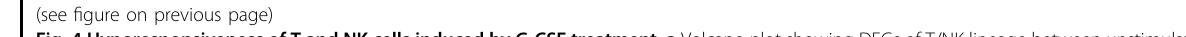
Fig. 4 Hyporesponsiveness of T and NK cells induced by G-CSF treatment. a Volcano plot showing DEGs of T/NK lineage between unstimulated BM and G-BM. DEGs were detected by differential expression analysis (two-sided Student ’ s t -test). Each dot represents a single gene; genes with log 2 (fold change) (logFC) < − 0.25 and logFC > 0.25 were selected and colored in blue and red, respectively. b Metascape network enrichment analysis of DEGs in T/NK cells in G-BM, with top 20 enriched terms and corresponding P values displayed at the bottom. Nodes were colored to re fl ect the memberships of enriched terms (left) and statistical P values (right). c Violin plots displaying the expression of key genes related to the IL-4 and IL-13 pathway, as well as apoptosis in T/NK cells after G-CSF treatment. Representative DEGs enriched in the IL-4 and IL-13 pathway and apoptosis in b are displayed. d GSEA plots of the enrichment of the Th2 versus Th1 signatures (top) and STAT3 targets (bottom) in CD4 + T cells in G-BM compared with unstimulated BM. P values adjusted with Benjamini – Hochberg correction and normalized enrichment score (NES) are displayed. e Box plot showing immunosuppression scores before and after G-CSF administration in CD4 + T cells. P values were calculated using the Wilcoxon-rank-sum test. **** P value < 0.0001. f Box plot showing the scores of the positive regulation of apoptosis before and after G-CSF administration in T/NK cells. **** P value < 0.0001. g Box plot showing the cytotoxicity scores before and after G-CSF administration in CD8 + T